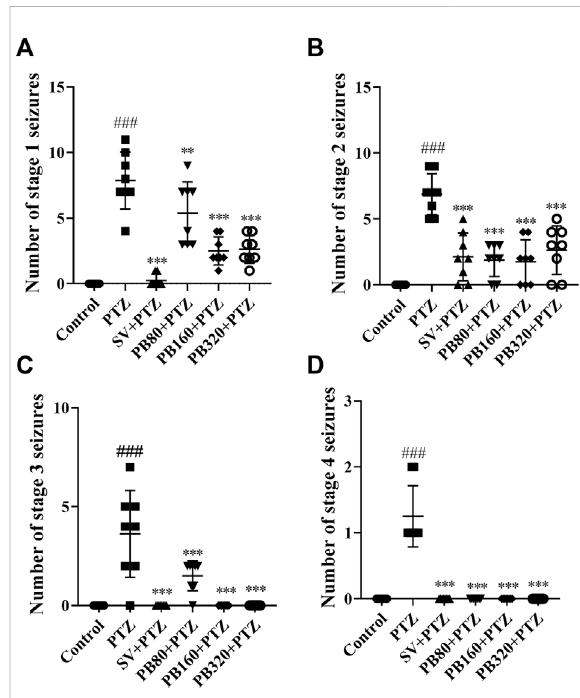
FIGURE 2 The aqueous extract of P. biglobosa decreased the mean number of seizures of stage 1 (A) and stage 2 (B) . Moreover, it protected the animals against seizures of stage 3 (C) and stage 4 (D) . Results are expressed as mean percentage ± SEM, N = 8. Data were analyzed by one-way ANOVA, followed by Tukey (HSD). ### p < 0.001; ## p < 0.01 compared to the control group and *** p < 0.001; ** p < 0.01; * p < 0.05 compared to the PTZ group. Control, normal control group only treated with distilled water; PTZ = negative control group treated with distilled water and PTZ; PB80, PB160, PB320 + PTZ, test groups treated with the aqueous extract of P. biglobosa (80, 160, and 320, respectively) and PTZ; SV + PTZ, positive control group treated with sodium valproate and PTZ. PTZ, pentylenetetrazole. SV, sodium valproate; PB, Parkia biglobosa